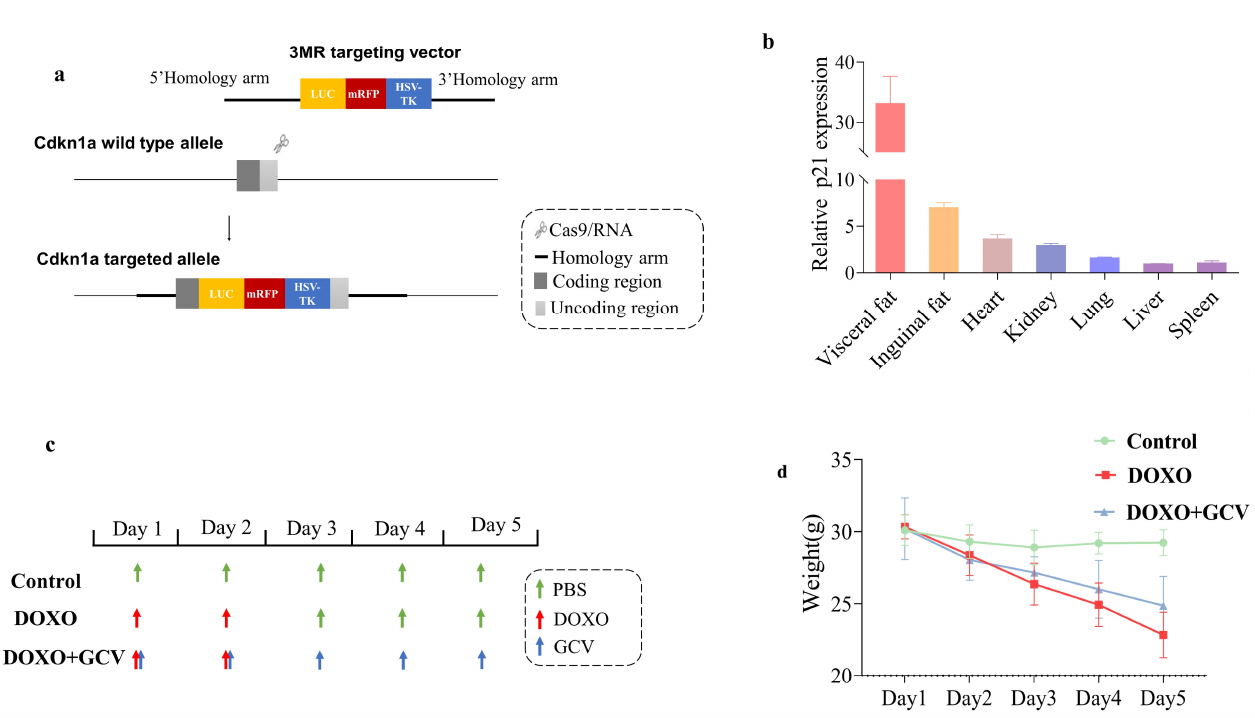
Figure 1. Generation of p21 ‐ 3MR mouse model. ( a ) Schematic of the p21 ‐ 3MR transgene. ( b ) P21 expression in vital organs from DOXO ‐ treated mice. ( c ) Experimental design, control group were given 2 doses of PBS; the DOXO group were given 2 doses of DOXO (10 mg/kg); the DOXO+GCV group were given 2 doses of DOXO, GCV was given immediately after DOXO treatment, a total of 5 doses. ( d ) Initial body weights of p21 ‐ 3MR mice from control/DOXO and DOXO+GCV group.